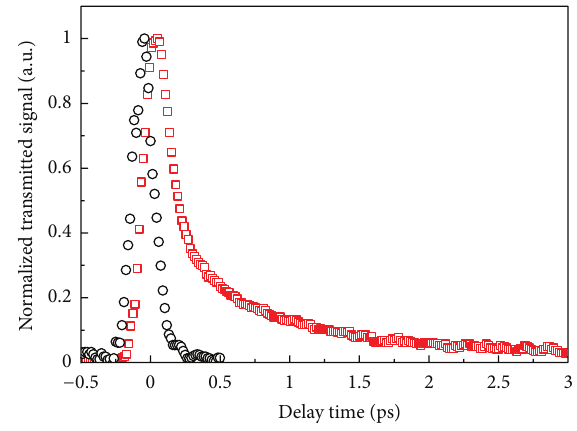
Figure 24: Normalized Kerr gate signal for CS 2 (open squares) and for the film with gold NPs (open circles). Laser wavelength: 800 nm. Beams’ intensities: 𝐼